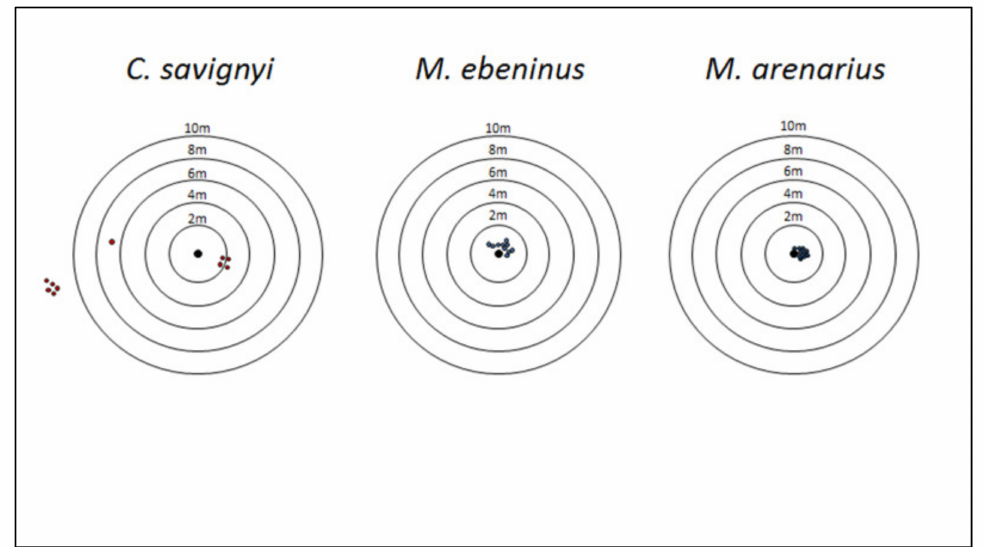
Figure A1. A graphic presentation of actual redispersal spatial patterns around a typical nest of each of the three ant species studied. The north is at the top of the diagram. The nest opening is the black point at the center of each diagram, and the circles contouring from it outwards are two meters apart one from the other. Each blue (for granivores) or red (for scavengers) point is the location of a seed removed from the